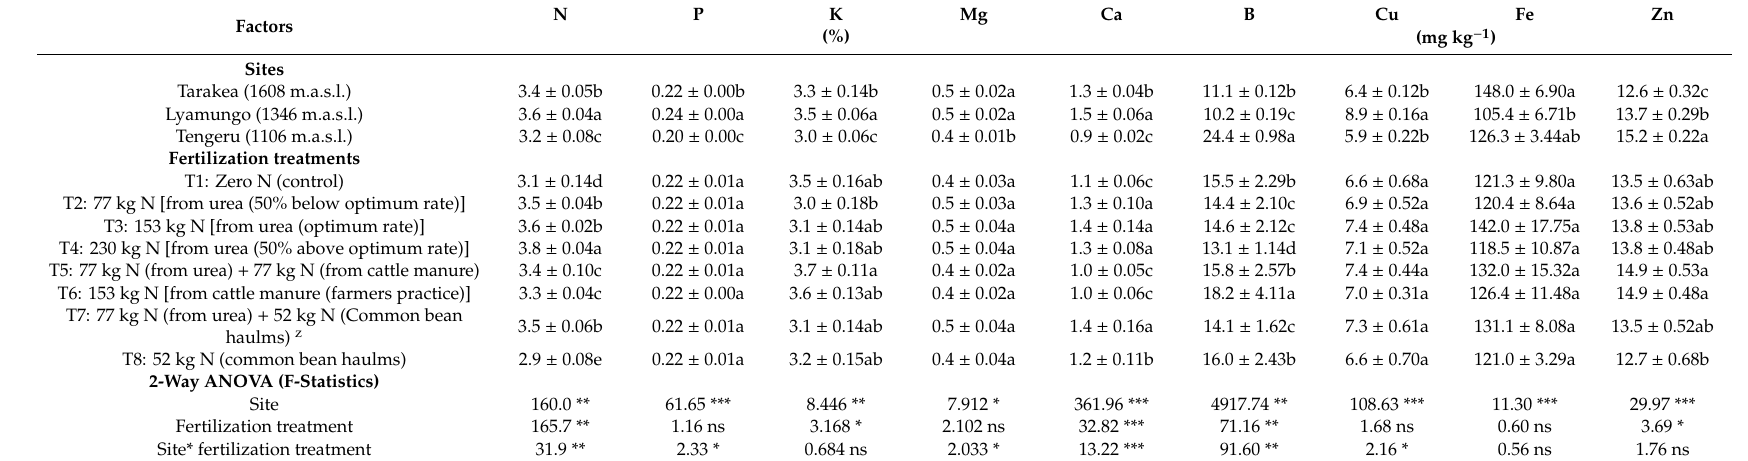
Table 5. E ff ects of fertilization treatments on nutrient concentrations in the third fully open leaf of nine month old Mchare plants at three sites located along the altitudinal gradients in volcanic soils of the northern highlands, Tanzania.